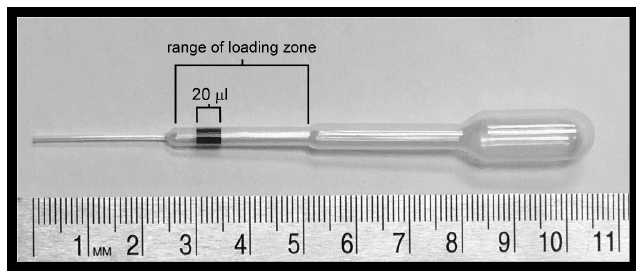
Figure 2. Loading of a Samco 231 disposable fine-tip pipette with HDCs. A 20 mL volume of opaque liquid has been loaded into this pipette. The numbers on the scale indicate centimeters.